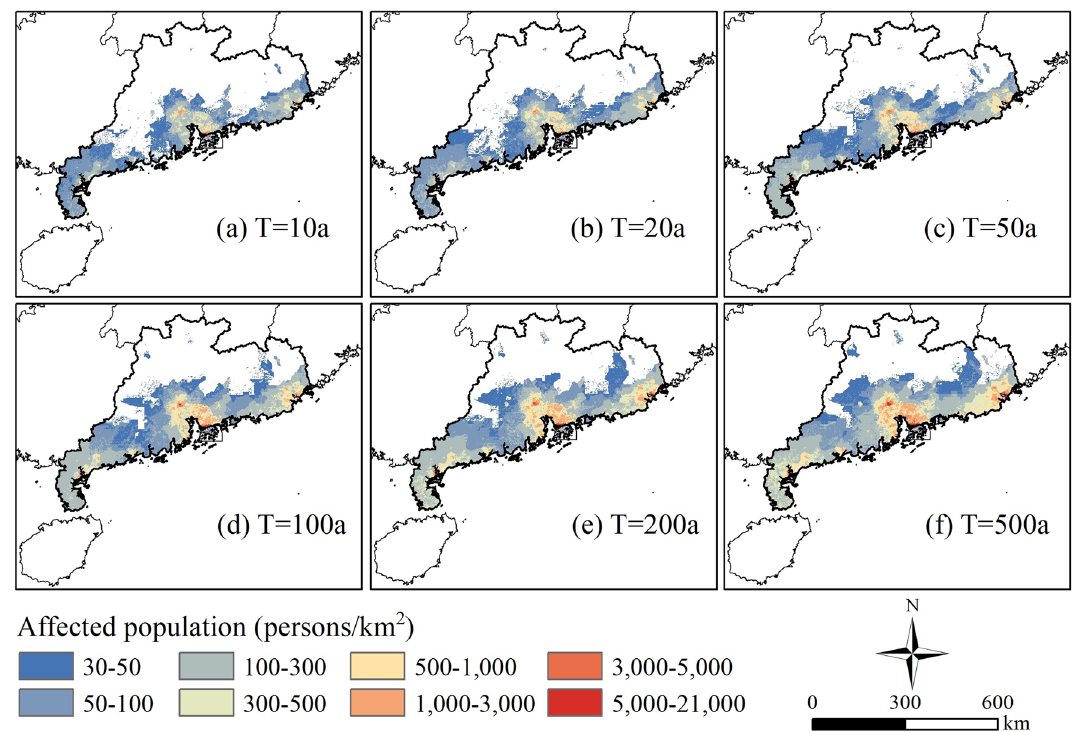
Fig. 8 Spatiotemporal distribution of affected population by tropical cyclones in six return periods in Guangdong Province, South